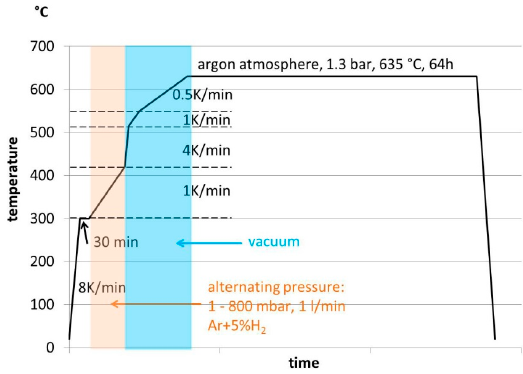
Figure 2. Sintering regime of the magnesium sintering process for MIM Mg ‐ 0.9Ca parts.